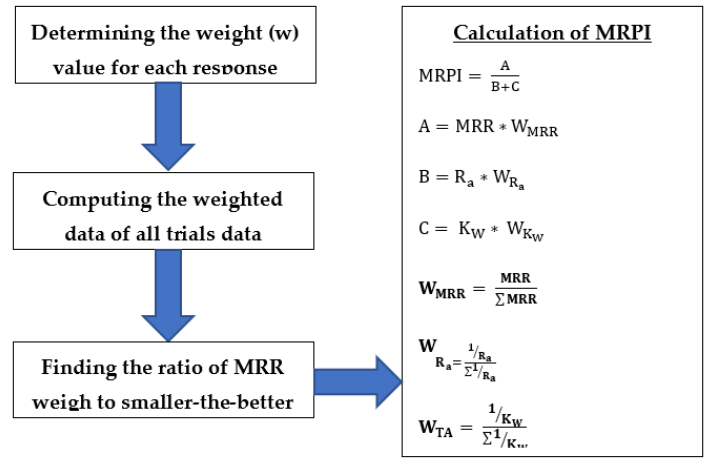
Figure 3. Steps involved in Taguchi-DEAR.